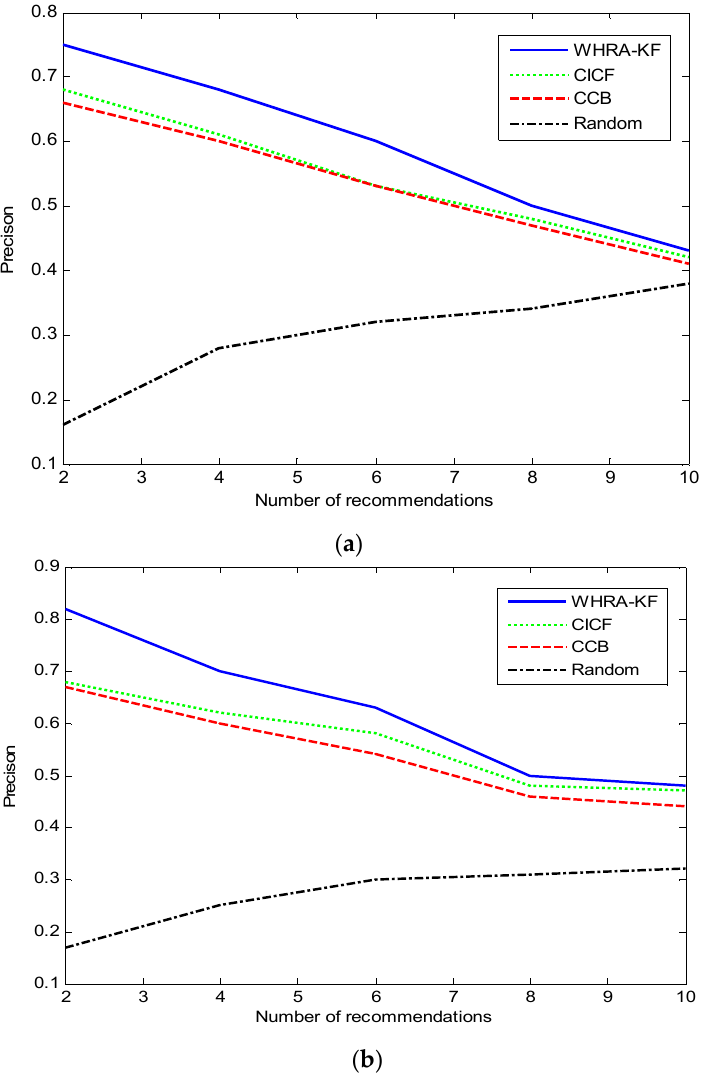
Figure 9. Precision VS number of recommendation for smart home, ( a ) 50 n ; ( b ) 100 n .